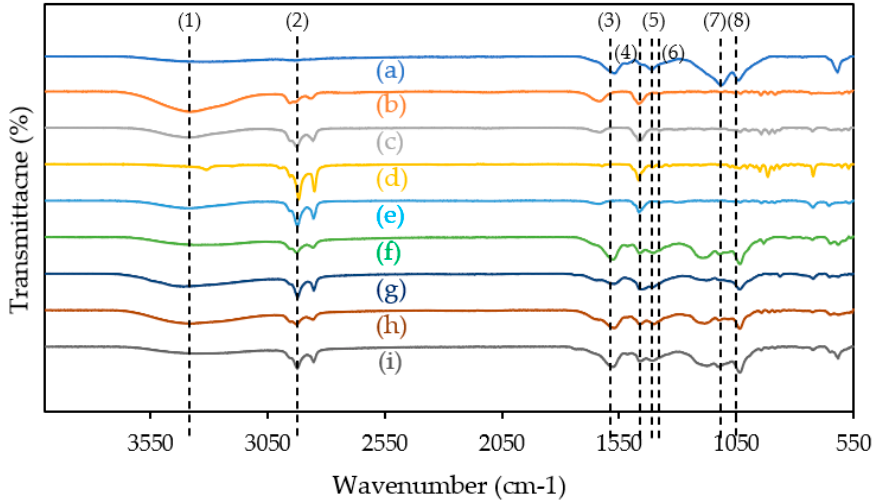
Figure 1. FTIR spectrum of (a) [Na] 2 [LS], (b) [C 6 C 1 Pip][Cl], (c) [C 8 C 1 Pip][Cl], (d) [C 12 C 1 Pip][Cl], (e)